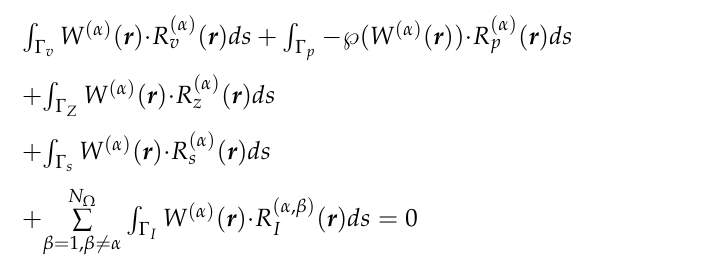
In this sub-domain, there are five kinds of boundary condition: Γ is the particle ve- v locity boundary condition (including acoustic rigid wall), Γ is the sound pressure p boundary condition, Γ is the acoustic impedance boundary condition, Γ is the vibro- Z s acoustic coupling boundary condition, and Γ is the acoustic continuity boundary con- I dition. On each kind of boundary, the residual function is defined as